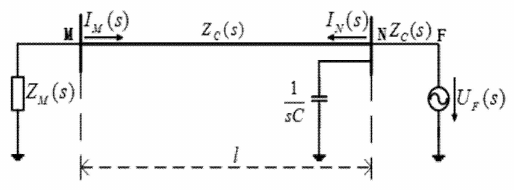
Figure 3. Additional network diagram of an external